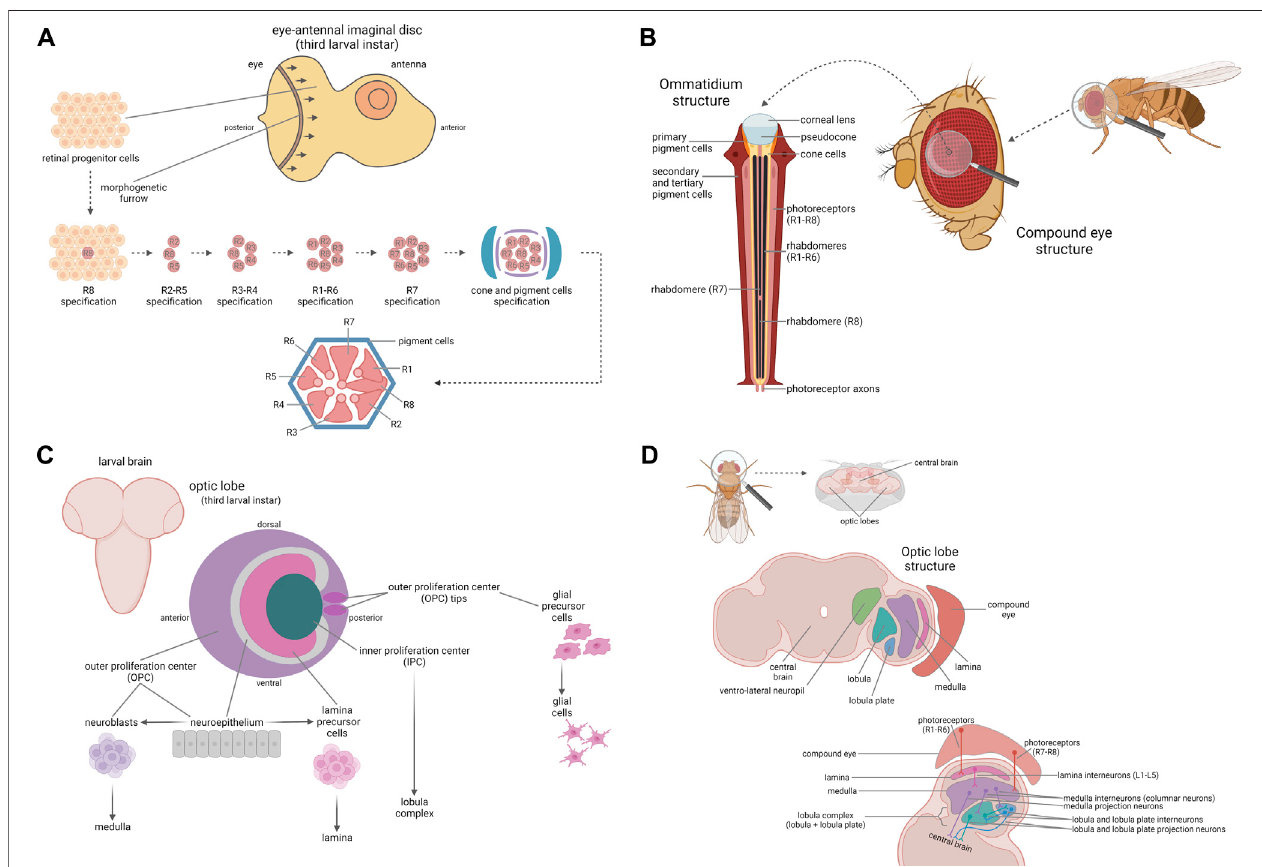
FIGURE 1 | Fly visual system. Development and anatomy of the compound eye. (A) The compound eye is derived from the eye-antennal imaginal disc, an epithelium giving rise to both the eye and the antenna. During the third larval instar, a posterior-to-anterior wave of differentiation occurs in the eye portion, leading to the differentiation of the retinal progenitor cells into all the cell types, depending on their positions. The fi rst cells undergoing speci fi cation are the photoreceptors, beginning with R8, followed by R2/R5, R3/R4, R1/R6, and R7, respectively, cone cells and pigment cells, which assemble to form the ommatidium fi nal structure, here represented in cross-section. (B) The compound eye is composed of ~800 units called ommatidia. Each ommatidium is composed of a corneal lens, a pseudocone, as well as cone and pigment cells, which form its backbone and are essential to focus the light on the photoreceptor neurons. In each ommatidium there are eight photoreceptorneurons(R1-R8),six “ outer ” (R1-R6)andtwo “ inner ” (R7-R8)ones,whichareresponsibleforphotoreceptionandforsignaltransductionfromtheretinato theopticlobes.Developmentandanatomyoftheopticlobe. (C) Theopticlobeisderivedfromaplate-likestructurenamedopticplacodeanditisorganizedintotheouter (OPC) and inner proliferation center (IPC). During larval development, the IPC and OPC give rise to the lobula complex and to the lamina, the medulla, and the glial cells respectively. The neuroepithelial cells composing the neuroepithelium of the OPC are converted into the lamina precursor cells in the inner part of the OPC and into the neuroblasts whichinturngeneratetheneuronsforming themedulla inthemedial part oftheOPC. Inaddition, thetipsoftheOPC represent theglialprecursorcell areas, which will differentiate into the glial cells of the optic lobe. (D) The optic lobe is composed of four neuropils: the lamina, the medulla, the lobula and the lobula plate. The laminaislocalizedneartheretinaandisinnervatedbytheouterphotoreceptorsR1-R6;laminainterneuronsL1-L5,targetedbyR1-R6axons,projecttothemedulla.The medulla is innervated by the inner photoreceptors R7 and R8 and by the lamina interneurons L1-L5; the medulla, similarly to the lamina, is mainly composed of interneurons, and in particular of columnar neurons projecting into the lobula complex. The lobula and the lobula plate, on the other hand, are mainly composed